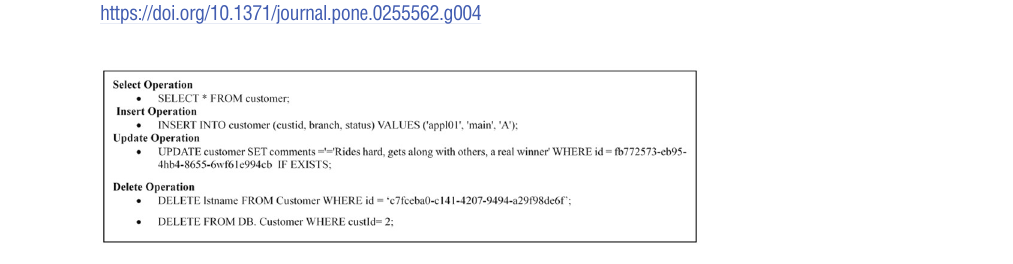
Fig 5. Cassandra libraries.